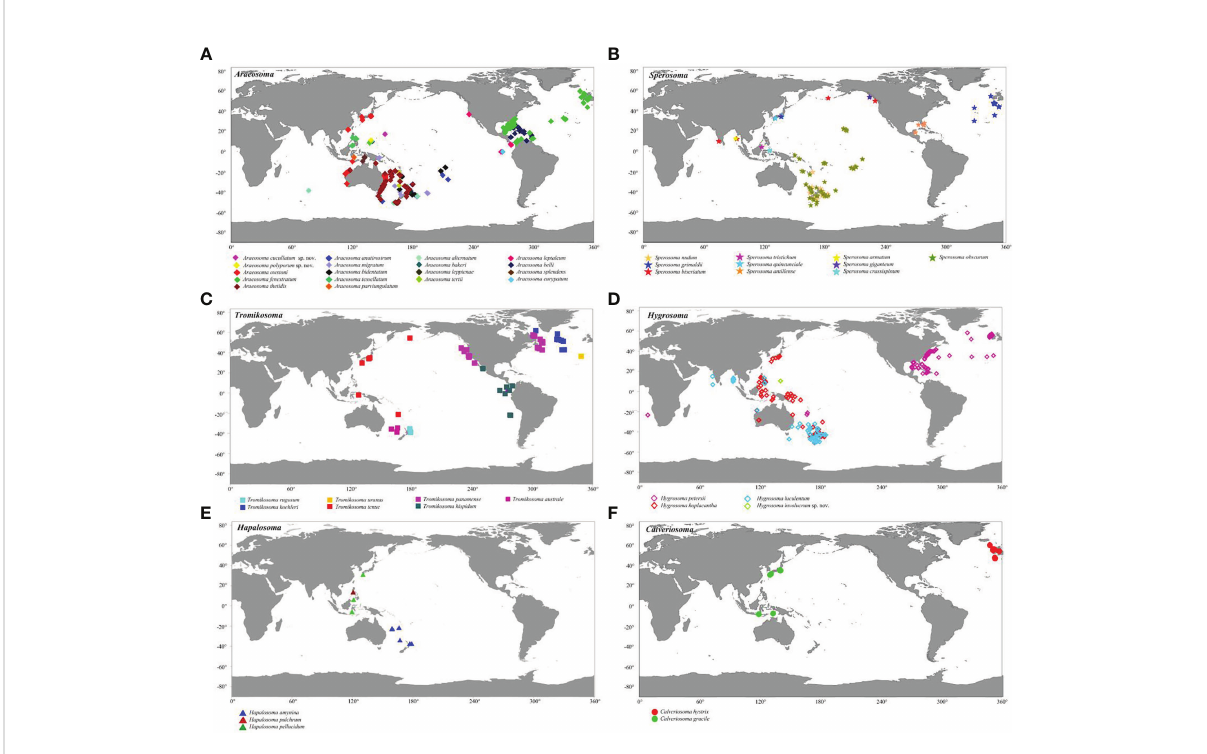
FIGURE 15 Distribution of deep-sea echinothuriid species based on the records of the Ocean Biodiversity Information System (https://obis.org/). (A) Araeosoma Mortensen, 1903. (B) Sperosoma Koehler, 1897. (C) Tromikosoma Mortensen, 1903. (D) Hygrosoma Mortensen, 1903. (E) Hapalosoma Mortensen, 1903. (F) Calveriosoma Mortensen, 1934. Colors denote different echinothuriid